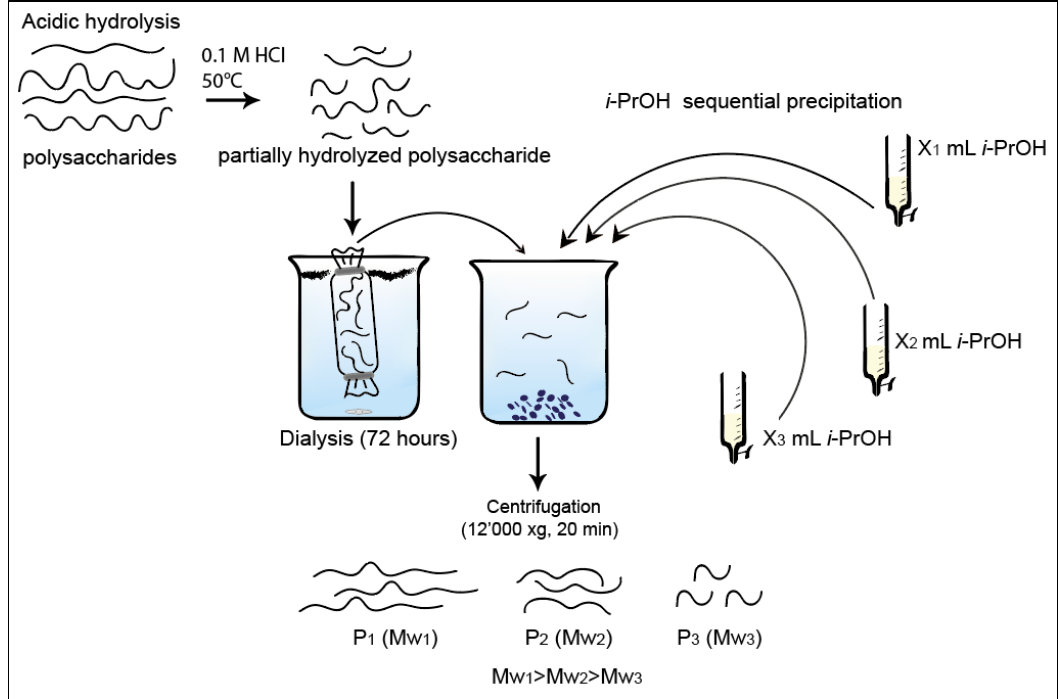
Figure 7. Scheme of partial hydrolysis and fractional precipitation of guar, wheat, and tamarind polysaccharides.